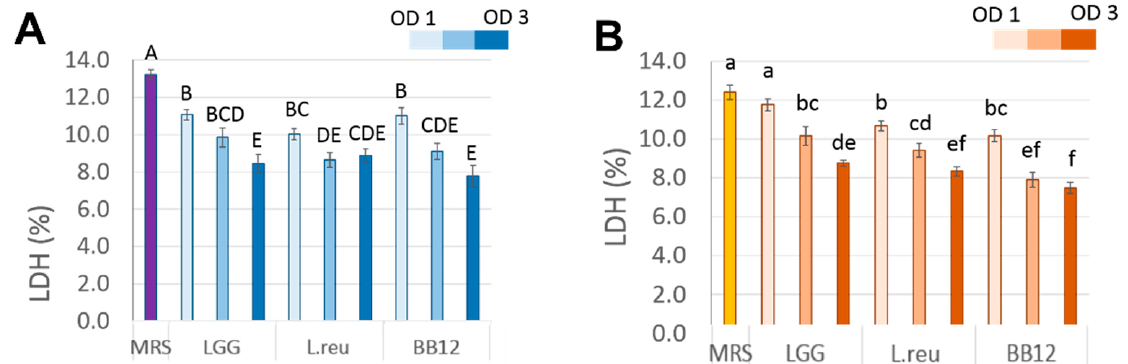
Figure 3. Postbiotics exhibit OD-dependent protective effects on cSiO 2 -induced cell death in: ( A ) the ASC cells; and ( B ) the WT cells after priming with LPS. The data are presented as mean ± SEM; biological triplicates were conducted. The capitalized letters indicate significant differences among ASC, while different lowercase letters indicate significant differences among WT ( p < 0.05).